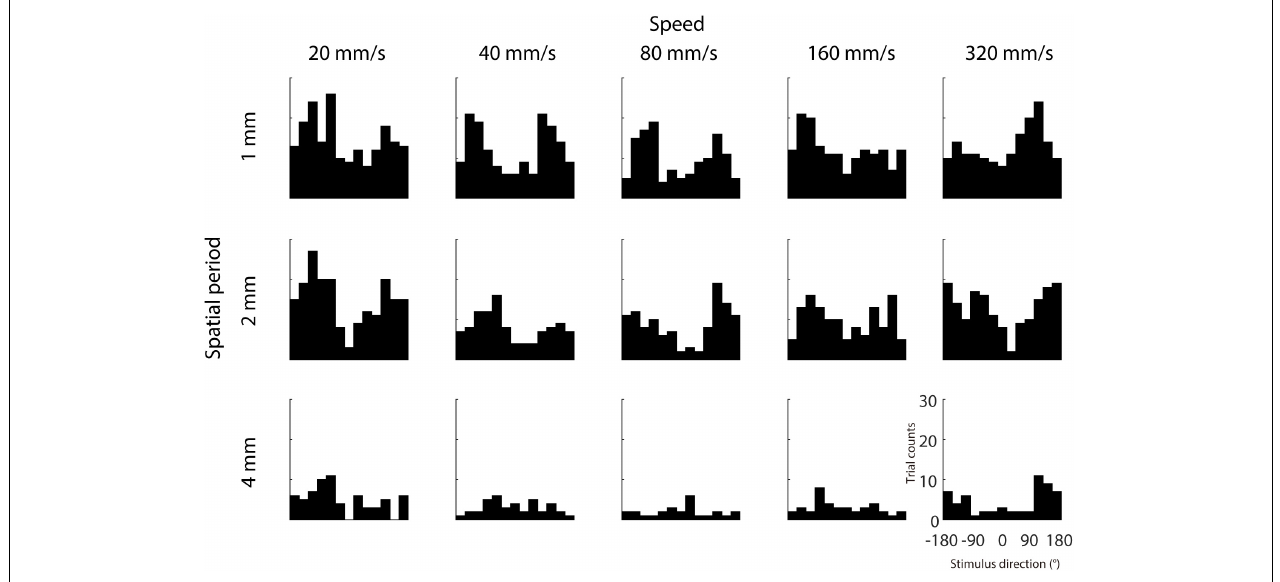
FIGURE 4 | Dependence of IMR on stimulus direction. We analyzed the distribution of stimulus directions that were putatively assigned to the IMR, by counting the trials with stimulus direction within range delimited by the range delimited by 180 ◦ perceptual bias ± 45 ◦ . Trial counts of IMR as a function of stimulus direction from each spatio-temporal combination. IMR tended to occur in certain stimulus directions (around 120 ◦ and –120 ◦ ) and spatio-temporal combinations.